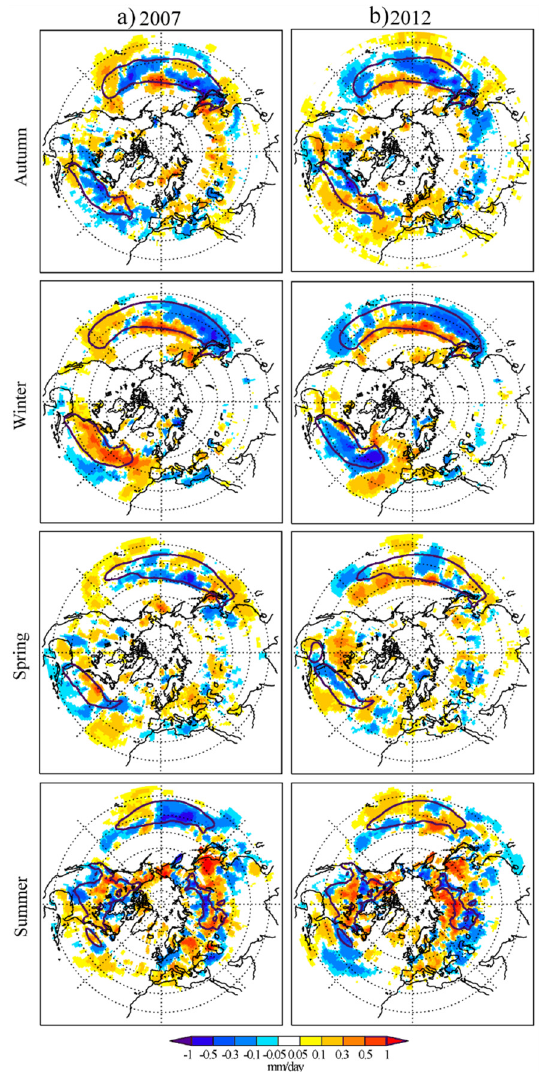
Figure 3. Seasonal evaporation–precipitation (E–P) > 0 anomalies for ( a ) 2006/2007 and ( b ) 2011/2012 compared with the 1980–2012 climatology. The reddish colours represent areas over which moisture uptake is greater that year (positive anomalies) and the bluish colours represent areas where moisture uptake is lower that year (negative anomalies). Contour magenta lines represent the main climatological moisture sources for the Arctic system based on the results of Vázquez et al. [47].